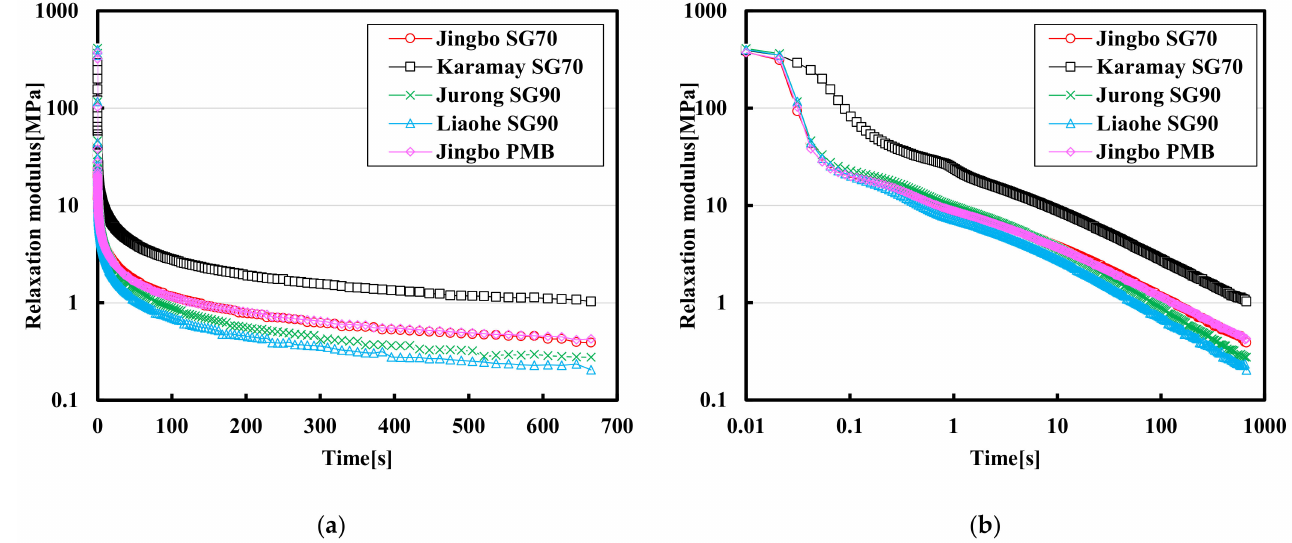
Figure 8. Modulus relaxation curves of semi-log scale ( a ) and log-log scale ( b ) of five hydraulic bitumen binders at − 25 ◦ C.